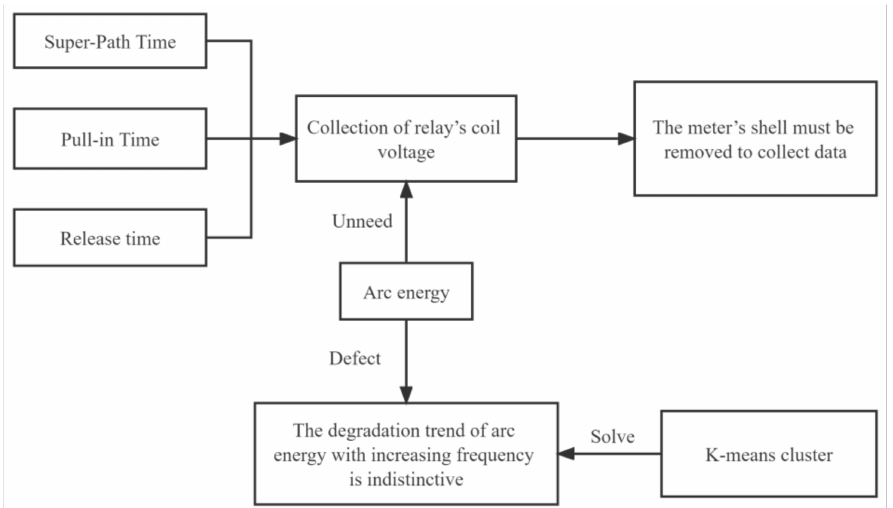
Figure 2. The reasons for selecting arc-burning energy as the input